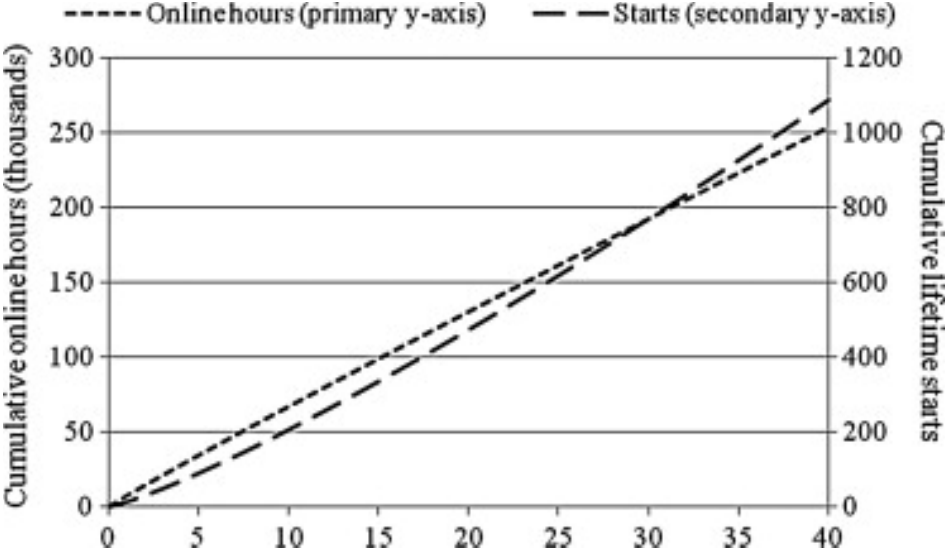
Figure 6. Power trend lines for creep life consumption. Adapted with permission from Ref. [52]. Copyright 2013 Applied Energy.